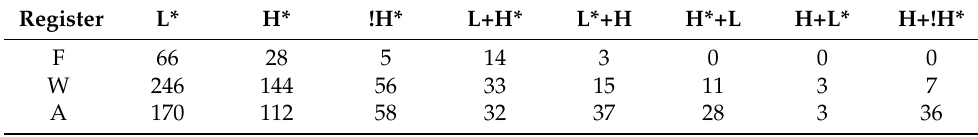
Table 2. Token count of all pitch accent labels, by register code.